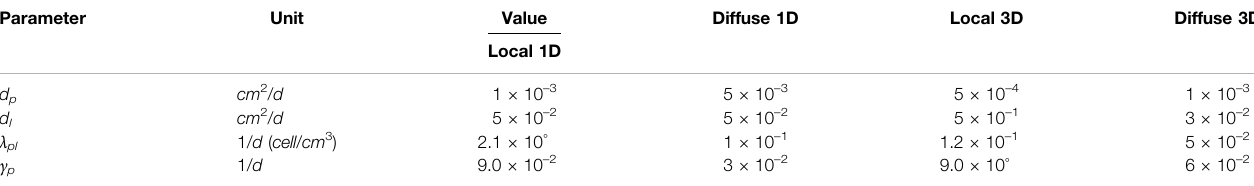
TABLE 2 | Parameter values used to represent local and diffuse myocarditis for the 1D and 3D simulations.